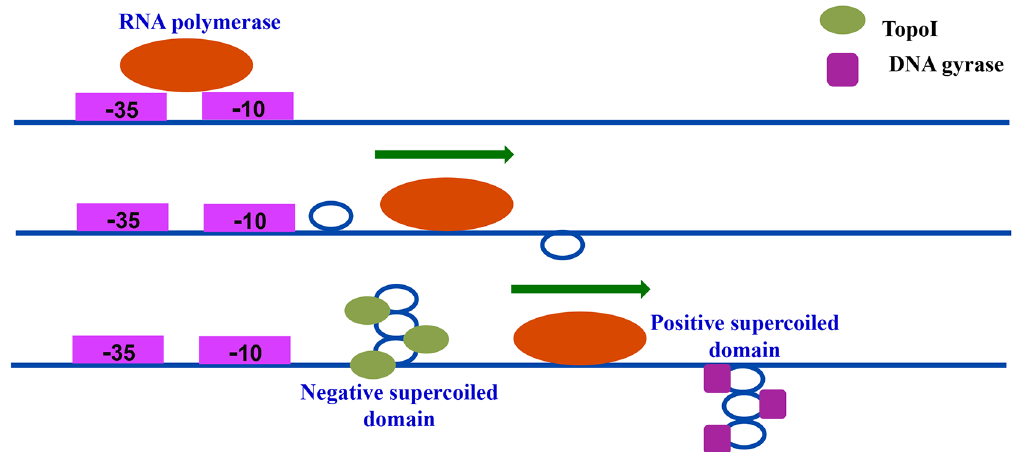
Fig 7. DNA topoisomerasesinteractwith the supercoiled domain on transcriptionally activeTUs. Advancement of RNApolymeraseon DNA templategenerates wavesof positivesupercoilsaheadandnegativesupercoilsbehind (Twin-supercoileddomain). Topo I is recruitedto sites wherenegativesupercoilsare prominent whileDNA gyrase occupies the regionwith positivesupercoils.Togethertheseenzymesmaintainthe transcription templatetopologyfor optimal